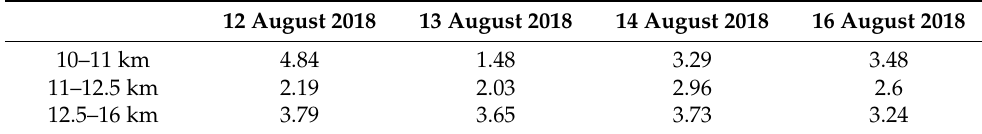
Figure 6. ( a ) Vertical profiles of potential temperature on 12–14 and 16 August 2018. ( b , c ) show magnified views of the 12.5–16 km and 10–12.5 km ranges, respectively. Table 4. Potential temperature lapse rate (K/km) within the range of 10–16